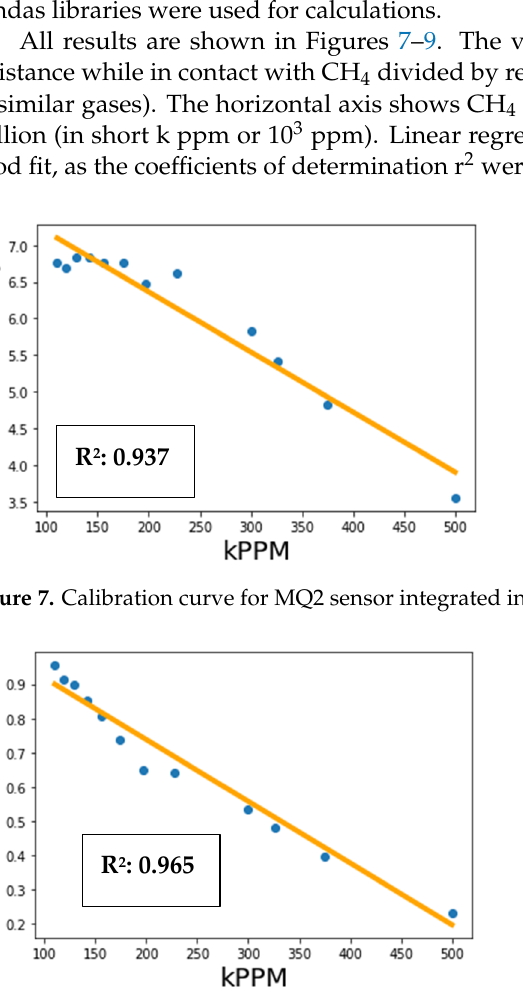
Figure 7. Calibration curve for MQ2 sensor integrated in a device. Table 1. OLS regression results (MQ2).